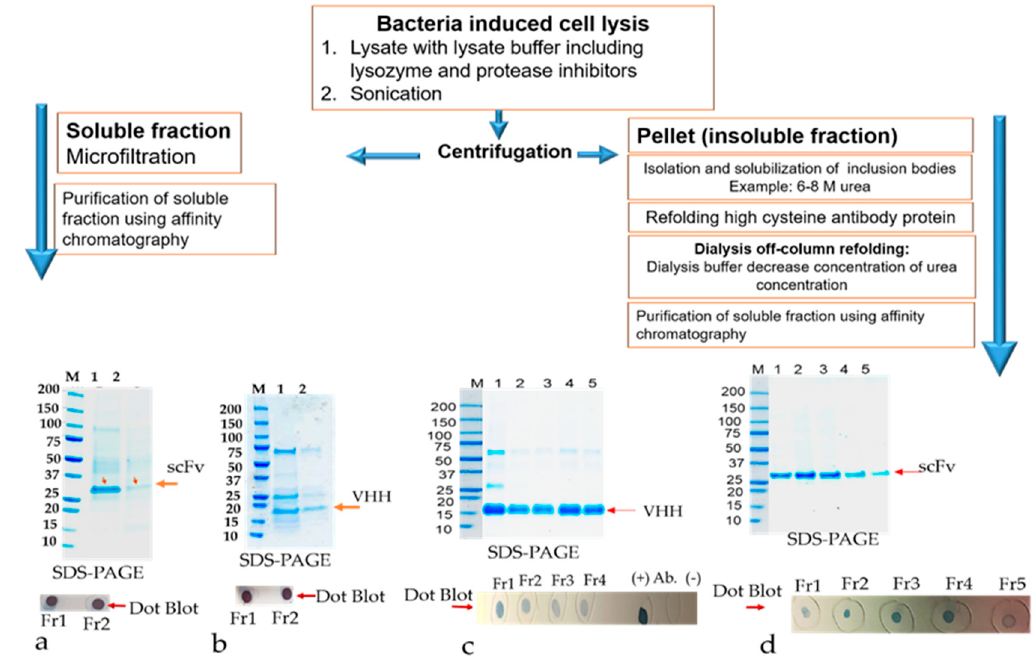
Figure 7. The affinity chromatography purification of rabbit scFv and VHH fragments using immobilized metal affinity chromatography (IMAC) after Abs refolding by the dilution method as described earlier. The soluble and IBs solubilization antibody purified fractions were loaded to the IMAC column, and bound proteins were eluted and analyzed by 4%–20% gradient SDS-PAGE under reducing conditions. ( a , d ) SDS-PAGE gel profile of the purified refolded fragment of RabscFv; ( b , c ) SDS-PAGE gel profile of purified VHH domain. The eluted fractions were analyzed by dot-blot analysis on the nitrocellulose membrane. The dot-blots of antibody proteins were performed using an anti-cmyc-HRP tagged monoclonal antibody, and the specific immunoreactive bands were visualized using TMB substrate. ( a,b ) Figure 7a,b represent soluble fraction Abs purified fractions, lane M indicates molecular weight, lanes 1–2 indicate purified fractions of interest of protein; RabscFv and VHH, respectively. ( c , d ) represent IBs solubilized Abs purified fractions, lane M indicates molecular weight, lanes 1–5 indicate purified fractions of interest of protein; VHH and RabscFv, respectively. Fr. indicates the elution fraction. Ab (+) indicates the control antibody. Ab ( − ) indicates PBS buffer.